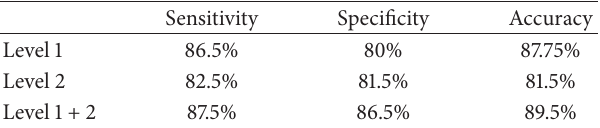
Table 4: Results obtained using the proposed feature in H channel.